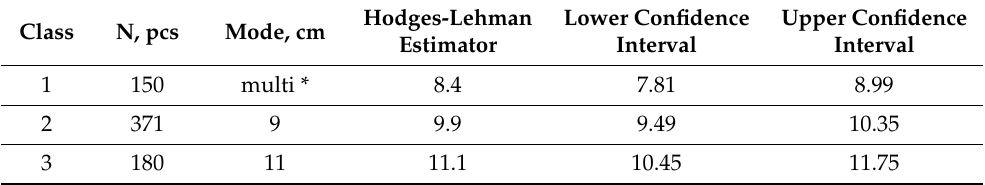
Table 6. The volume of classes of the provenance factor and the amplitude of indicators of DBH in